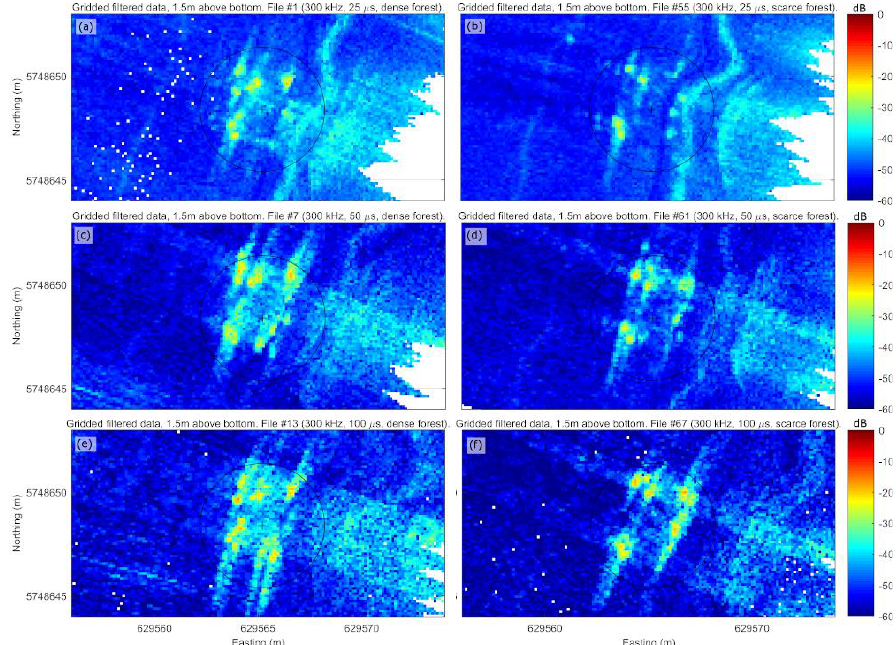
Figure 9. Horizontal slice-through at 1.5 m above the seafloor for a file acquired at 300 kHz over the dense or thin forest patch, using different pulse length settings: ( a ) 25 μs pulse data on dense forest, ( b ) 25 μs pulse data on thin forest, ( c ) 50 μs pulse data on dense forest, ( d ) 50 μs pulse data on thin forest, ( e ) 100 μs pulse data on dense forest, ( f ) 100 μs pulse data on thin forest. The cross is the centre of the patch. The 3 m radius circle is the base of the target volume. Remote Sens. 2020 , 12 , x FOR PEER REVIEW